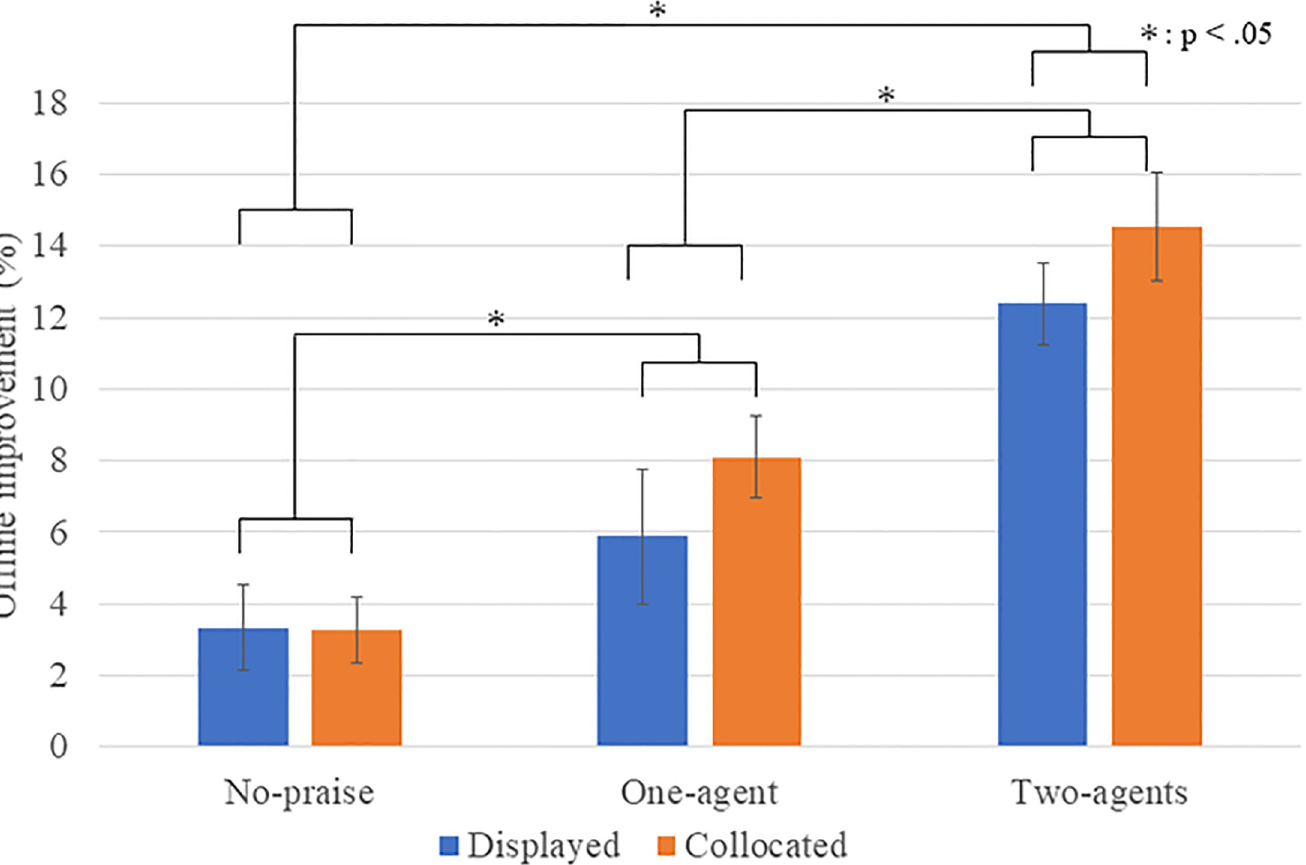
Fig 6. Rate of offline improvement: Vertical axis indicates percentage of increase from mean performance of day 1 to 2.